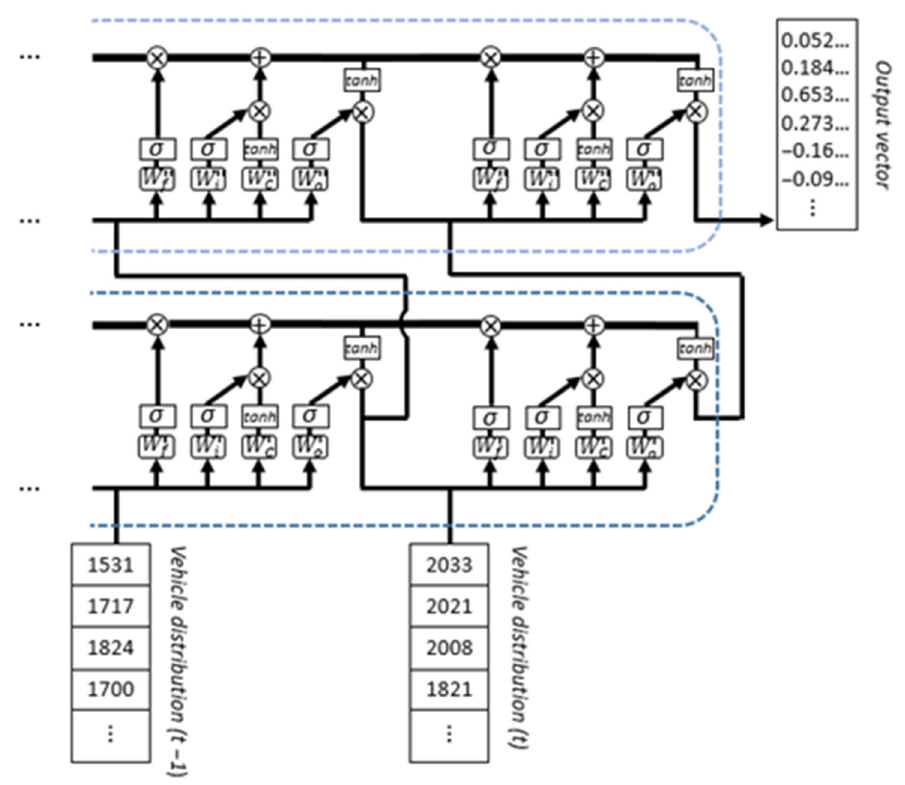
Figure 4. Visual schema reporting the last two steps of a sequence of vehicle flows, processed by a recurrent block of two LSTM layers.